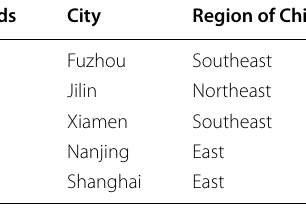
Table 1 Description of data used in this study Data